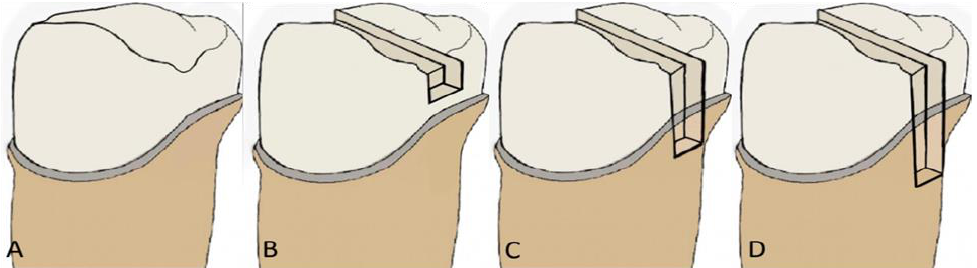
Figure 1. Schematic representation of groups. Group ( A ): Teeth with full-contour crowns without cavity preparation (control group). Group ( B ): Teeth with mesio-occluso-distal (MOD) prepara- tion/restoration with full-contour crowns (gingival seat 2 mm above the crown margin). Group ( C ): Teeth with MOD preparation/restoration with DME and full-contour crowns (2 mm DME to crown margin). Group ( D ): Teeth with MOD preparations with DME and full-contour crowns (4 mm DME to crown margin).